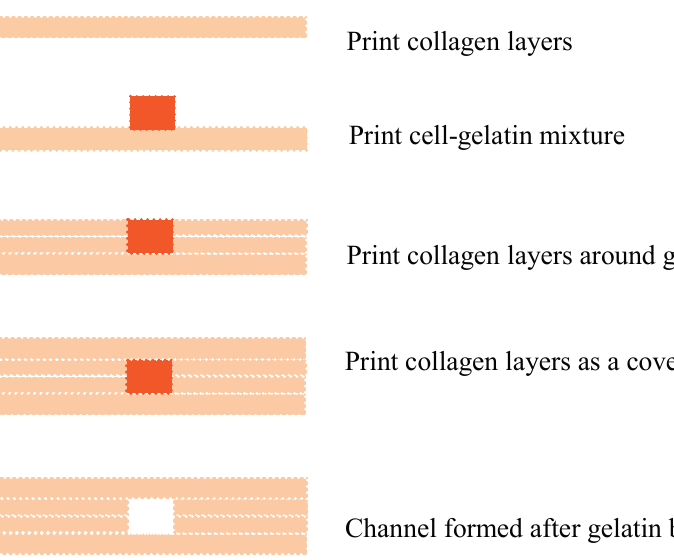
Figure 5. Bioprinting for fabrication of multi-level tubular constructs. With a layer-by-layer printing approach, the collagen precursor was printed and polymerized. Then gelatin/cell mixture was printed in a straight pattern to take the position of the channel. After gelation, more collagen layers were printed to cover the gelatin pattern. The vascular structure was formed after gelatin was